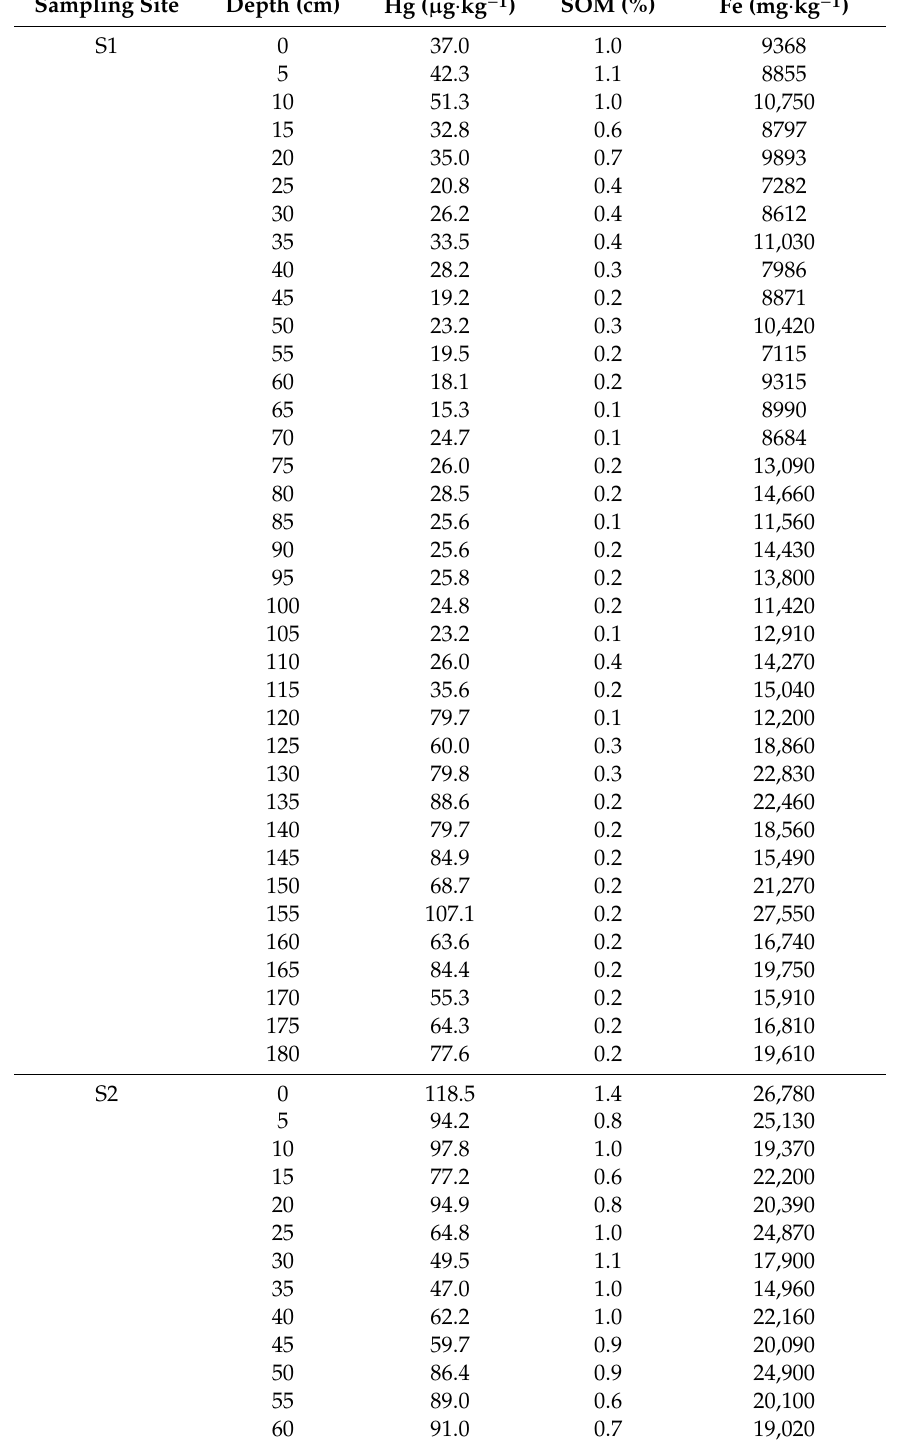
Table A1. Data for Hg, SOM, and Fe contents in each soil